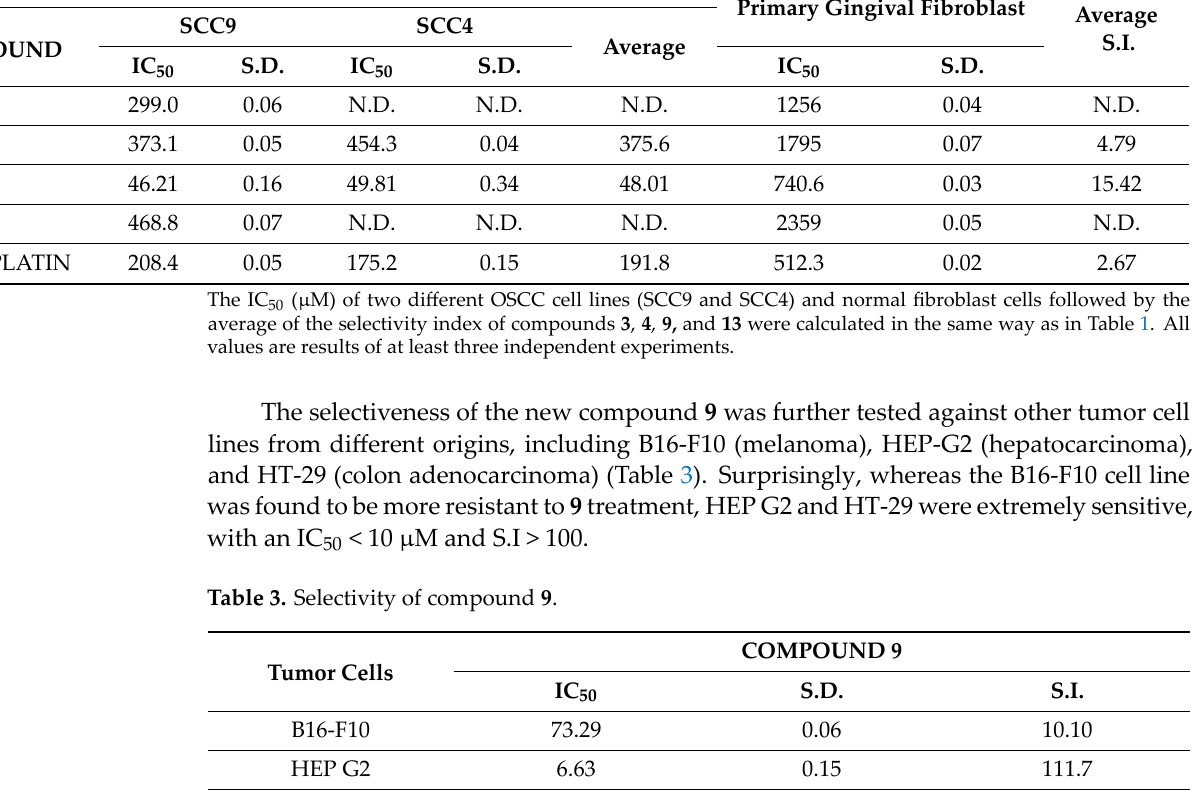
Table 2. Characterization of the most selective compounds in other OSCC cells. Oral Tumor Cells